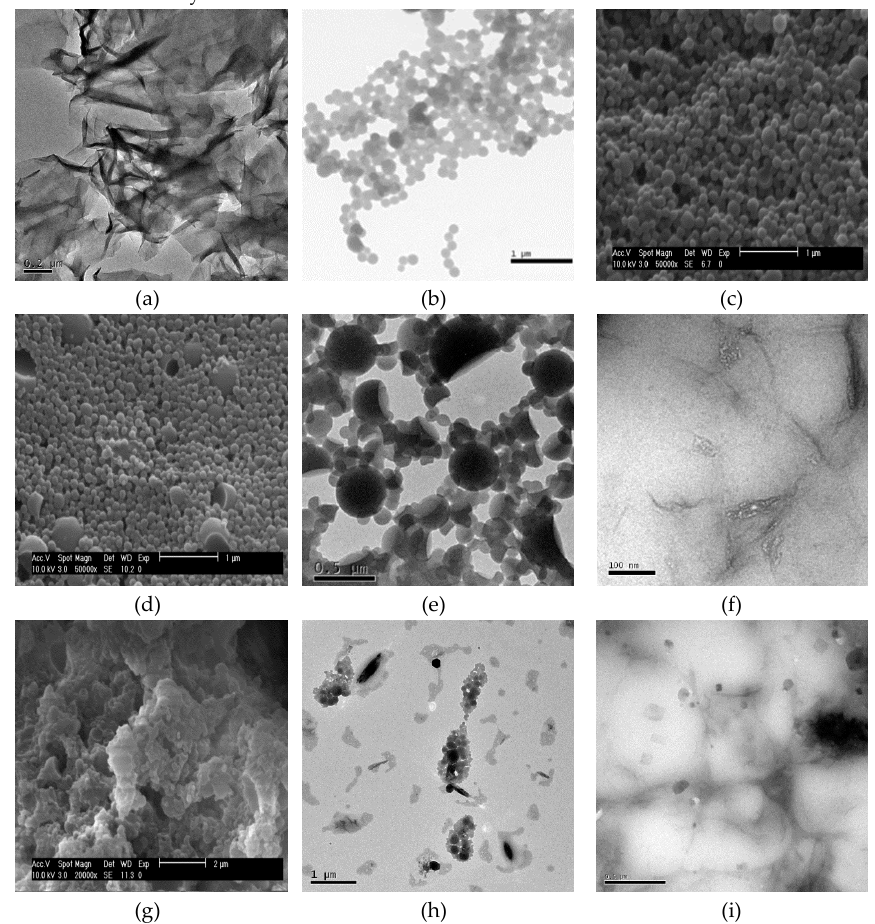
Figure 8. Images of ( a ) TEM of VBTAC modified GO after sonication; ( b ) TEM and ( c ) SEM of neat PMMA nano-droplets; ( d ) SEM and ( e ) TEM of miniemulsions; ( f ) TEM of the melted film of nanocomposites of the VBTAC modified GO (0.5%) encapsulated by PMMA; ( g ) SEM and ( h ) TEM of miniemulsions and ( i ) TEM of the melted film of nanocomposites of untreated GO (0.5%) with